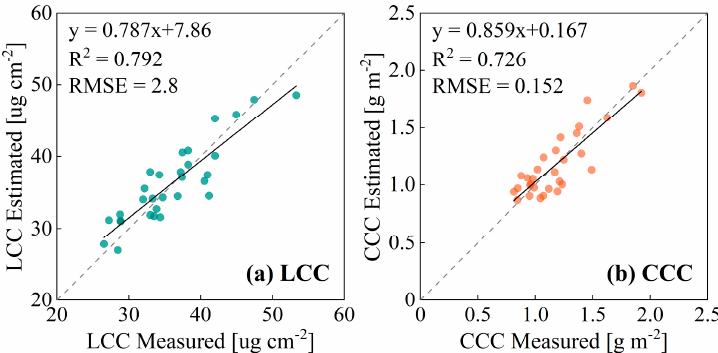
Figure 4. Relationship between the measured and retrieved ( a ) LCCs and ( b ) CCCs at Youyi Farm using the hybrid model with the AL strategy and Sentinel-2 imagery with 10 bands.